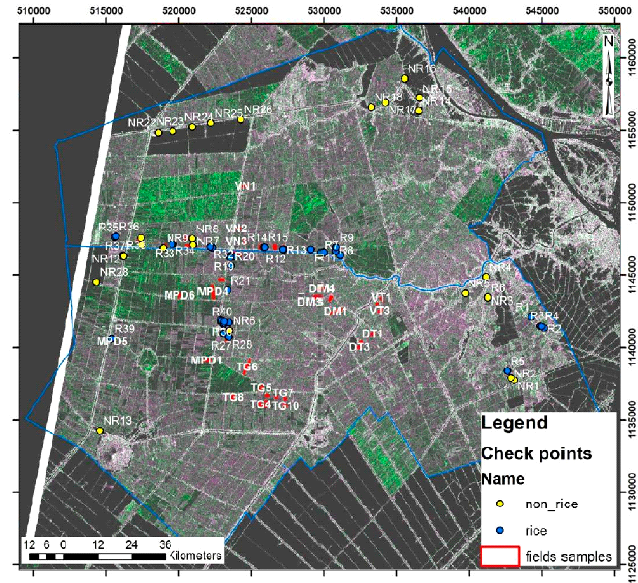
Figure 3. Forty rice field samples and 64 rice (blue points)/non-rice (yellow points) check points used for result validation. CSK image (magenta: HH, green: VV) of the Chau Thanh and Thoai Son districts, An Giang Province, 19 August 2013.